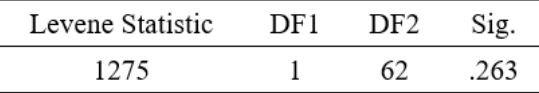
Table 5. Results of homogeneity test